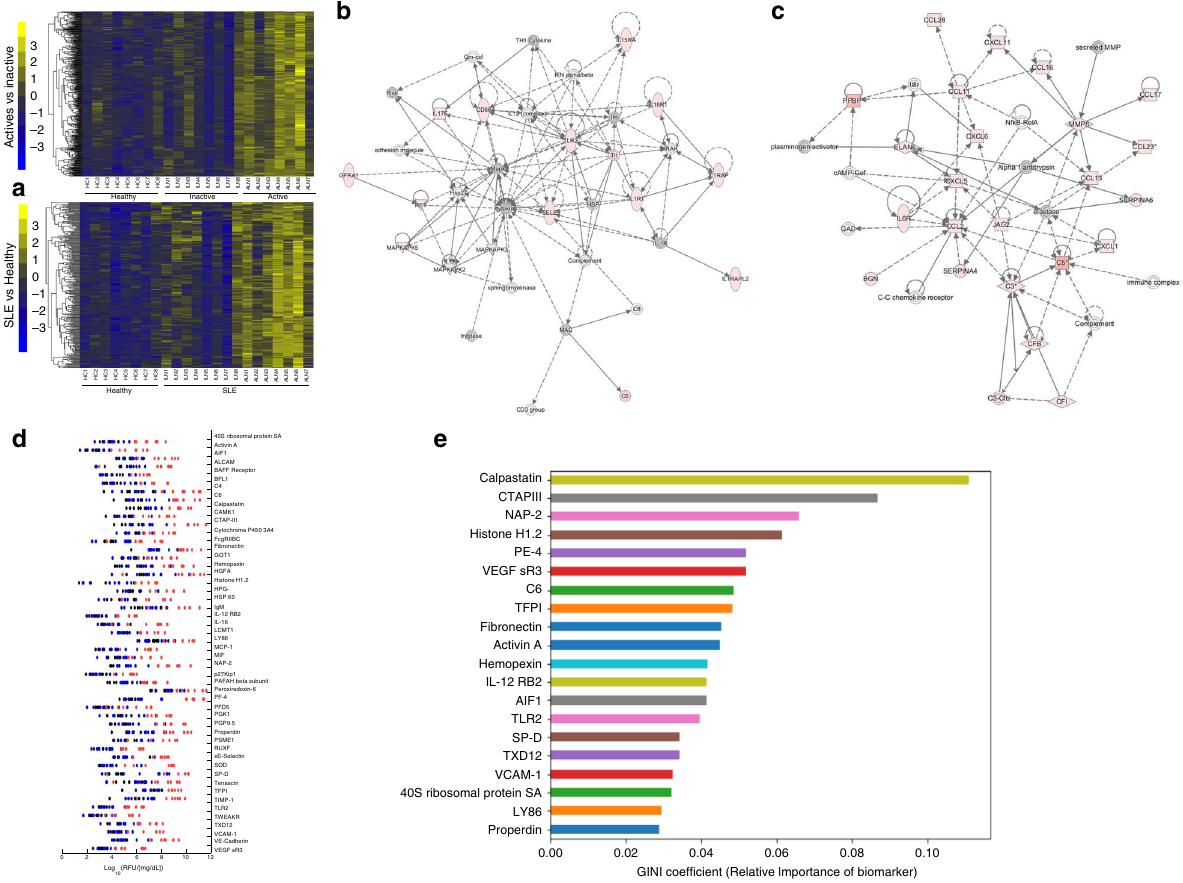
Fig. 1 Aptamer-based screening of lupus nephritis urine samples for 1129 proteins. a Heatmap representation of aptamer-based screening results of the 1129 proteins analyzed in 23 human urine samples (7 active LN, 8 inactive SLE, 8 healthy controls). 284 urinary proteins were found to be elevated ( p < 0.05, fold-change ≥ 2, Mann – Whitney U -test) when comparing active LN to inactive SLE (top), while 326 urinary proteins were elevated ( p < 0.05, fold- change ≥ 2; Mann – Whitney U -test) when comparing all SLE subjects to healthy controls (bottom). Each map shows the relative concentrations of these proteins after normalizing against urinary creatinine. Each column represents a patient sample, while rows correspond to a creatinine-normalized protein level measured using the screening assay. Proteins that are above the mean value (for each biomarker) are yellow, while those below are blue, with proteins comparable to the mean value are black. b , c The proteins that were signi fi cantly elevated in the urine of patients with active LN clustered into 20 pathways with at least 10 upregulated proteins each, as determined by Ingenuity Pathway Analysis, of which 2 are displayed. Additional pathways are included in Supplementary Data. Molecules elevated in LN urine are shaded pink. Documented and putative interactions between the displayed molecules are indicated by solid and interrupted arrows, respectively, based on literature review. d The 50 urine proteins (ranked in order of fold-change) that were signi fi cantly elevated in active LN compared to inactive SLE are displayed. Further details regarding these proteins are in included in Supplementary Data (red dots represent active LN; blue dots represent inactive SLE; black dots represent healthy controls). e Random forest classi fi cation analysis identi fi cation of the 20 most discriminatory urine proteins with the largest impact on distinguishing the study groups, ordered by their GINI coef fi cient. Source data are provided as a Source Data fi